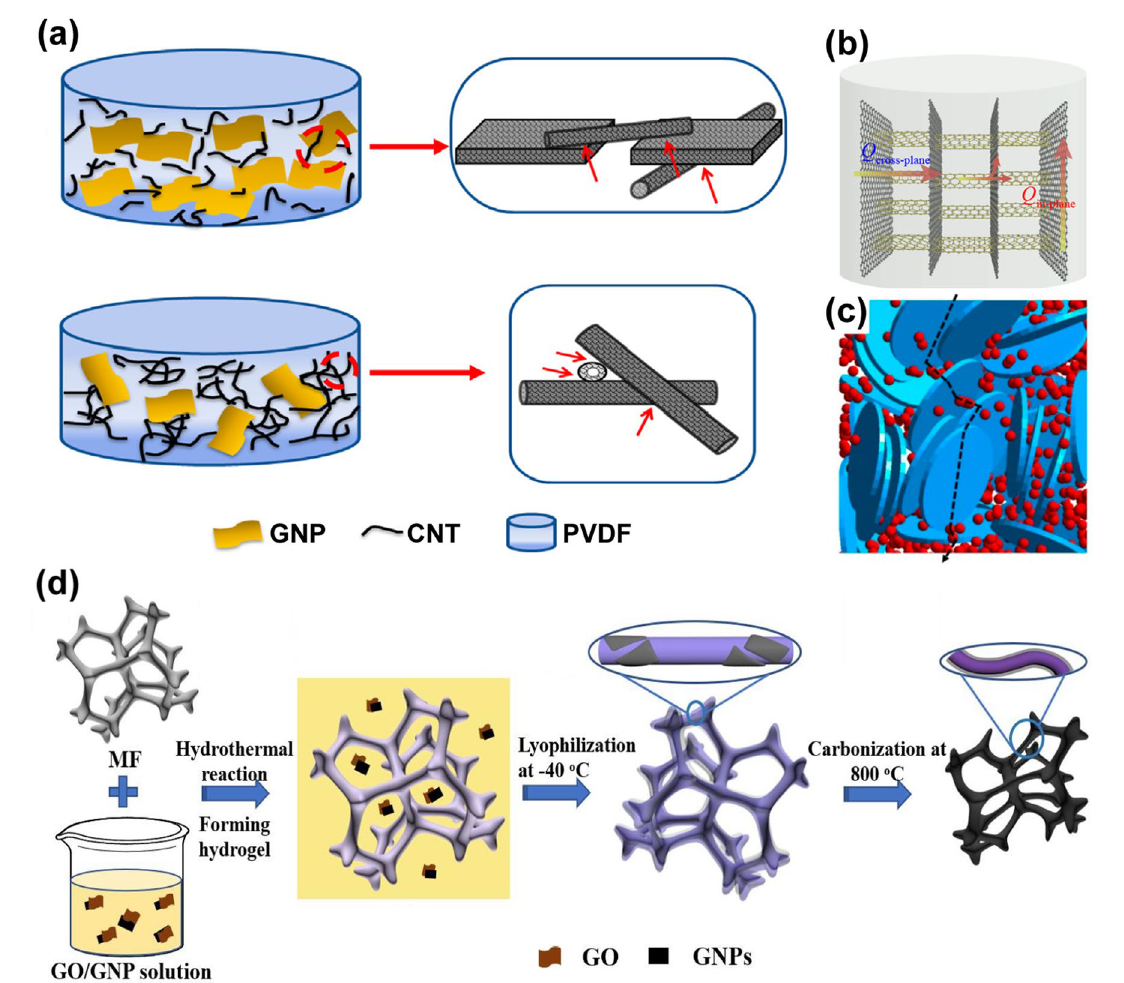
Fig. 17 a, b Schematic illustrations of synergies of GNPs and CNTs on thermal conduction [62, 251]. c Schematic illustrations of synergies of GNPs (blue slices) and BN (red spheres) [65]. d Schematic illustrating the preparation of graphene/MF foam and the derived